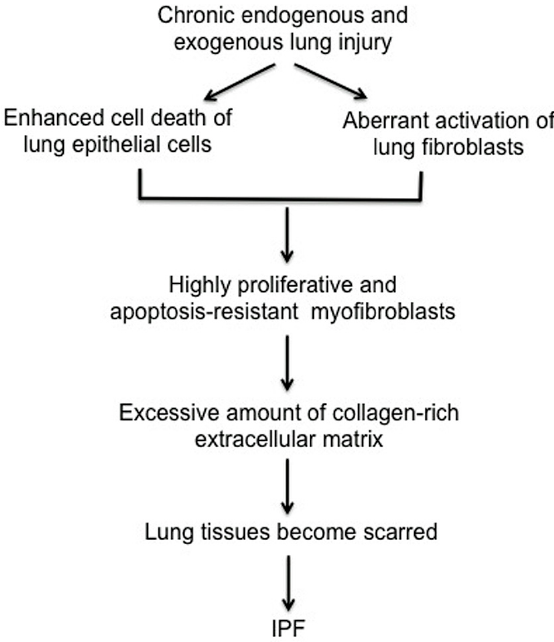
Figure 1. Proposed model for IPF. Chronic lung injury promotes lung epithelial cell death while (myo)fibroblasts become activated as a result of fibrosis inducing growth factors and cytokines. The failure of re-epithelization and hyper-proliferation of (myo)fibroblasts relentlessly produce collagen rich extracellular matrix, which promotes the fibrotic process, leading to the progression of lung fibrosis.